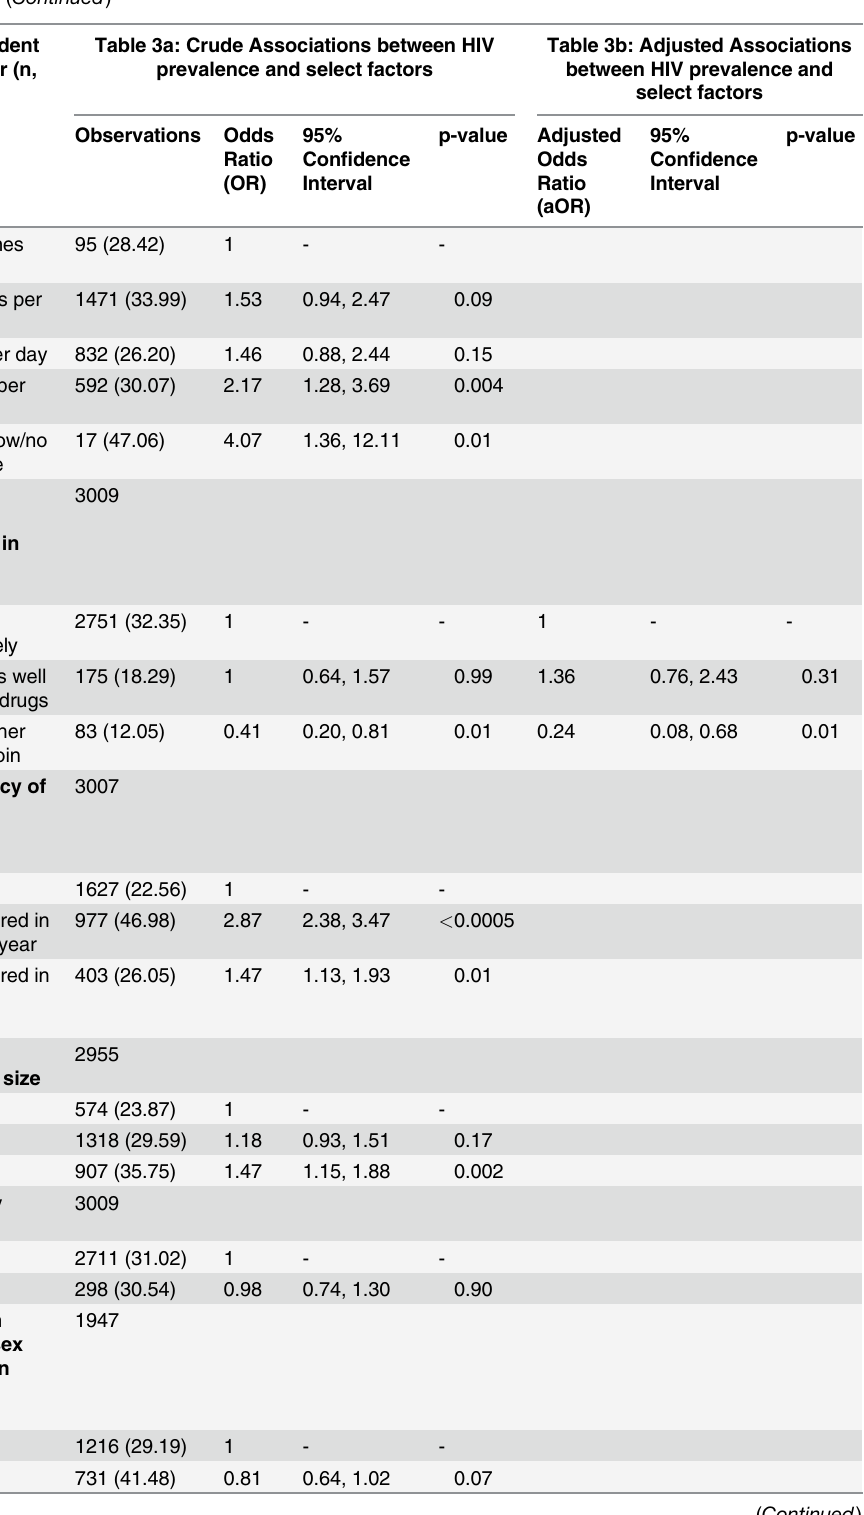
Table 3a: Crude Associations between HIV prevalence and select factors